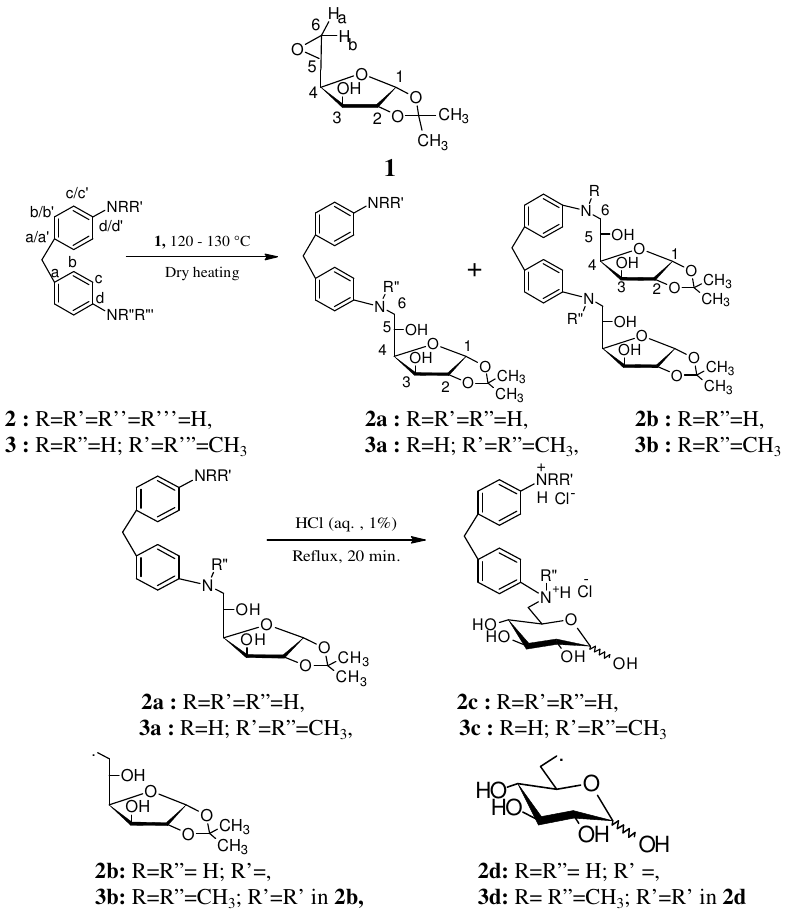
Figure 1. Structures of “Molecular tweezers” used in present